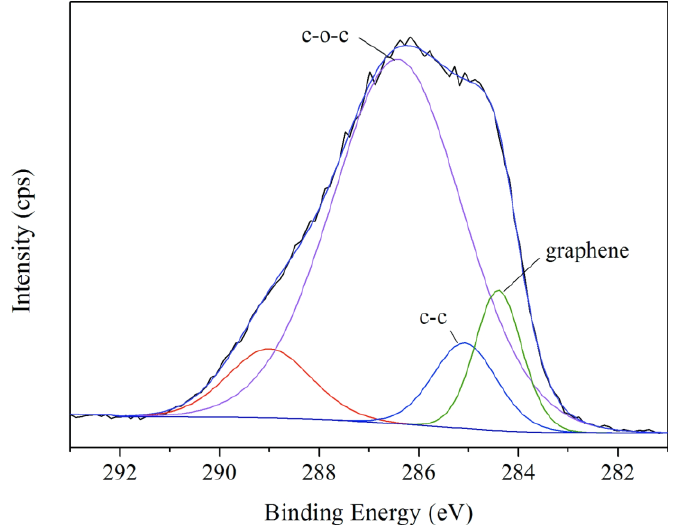
Figure 6. XPS spectra (C1s) of microcapsules with 2% graphene in shells.